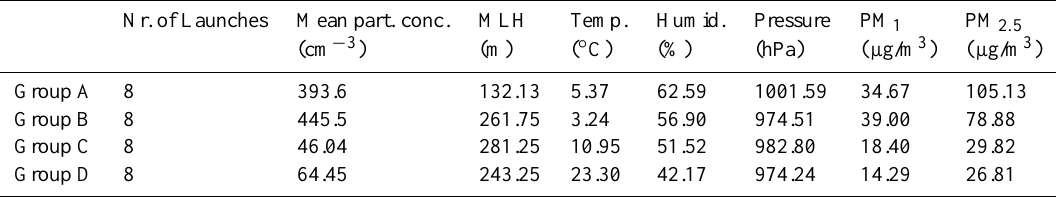
Table 5. Descriptive statistics for homogeneous sub-groups entering in model estimation. Nr. of Launches Mean part. conc. MLH Temp.